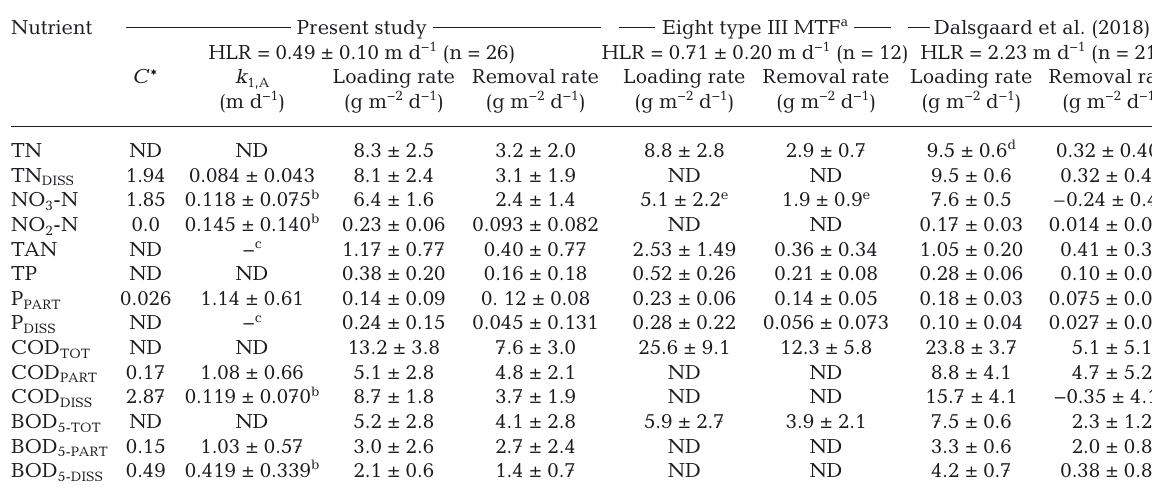
Table 2. Background concentrations ( C *; cf. Dalsgaard et al. 2018), yearly average first-order removal rate constants derived in the present study ( k 1,A ), and yearly average nutrient loading rates and removal rates (mean ± SD) measured during a year in different model trout farm (MTF) wetlands with different hydraulic loading rates (HLRs). TN: total N; TAN: total ammonia N; TP: total P; COD: chemical oxygen demand; BOD: biochemical oxygen demand; DISS: dissolved, PART: particulate; TOT: